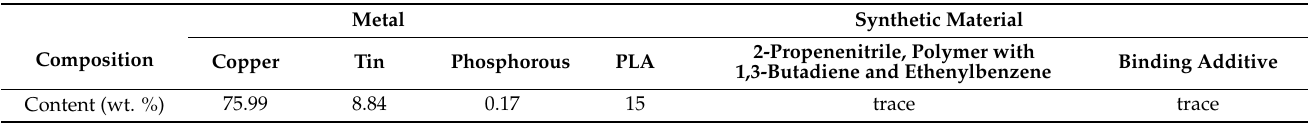
Table 1. Composition of bronze/PLA hybrid filament.